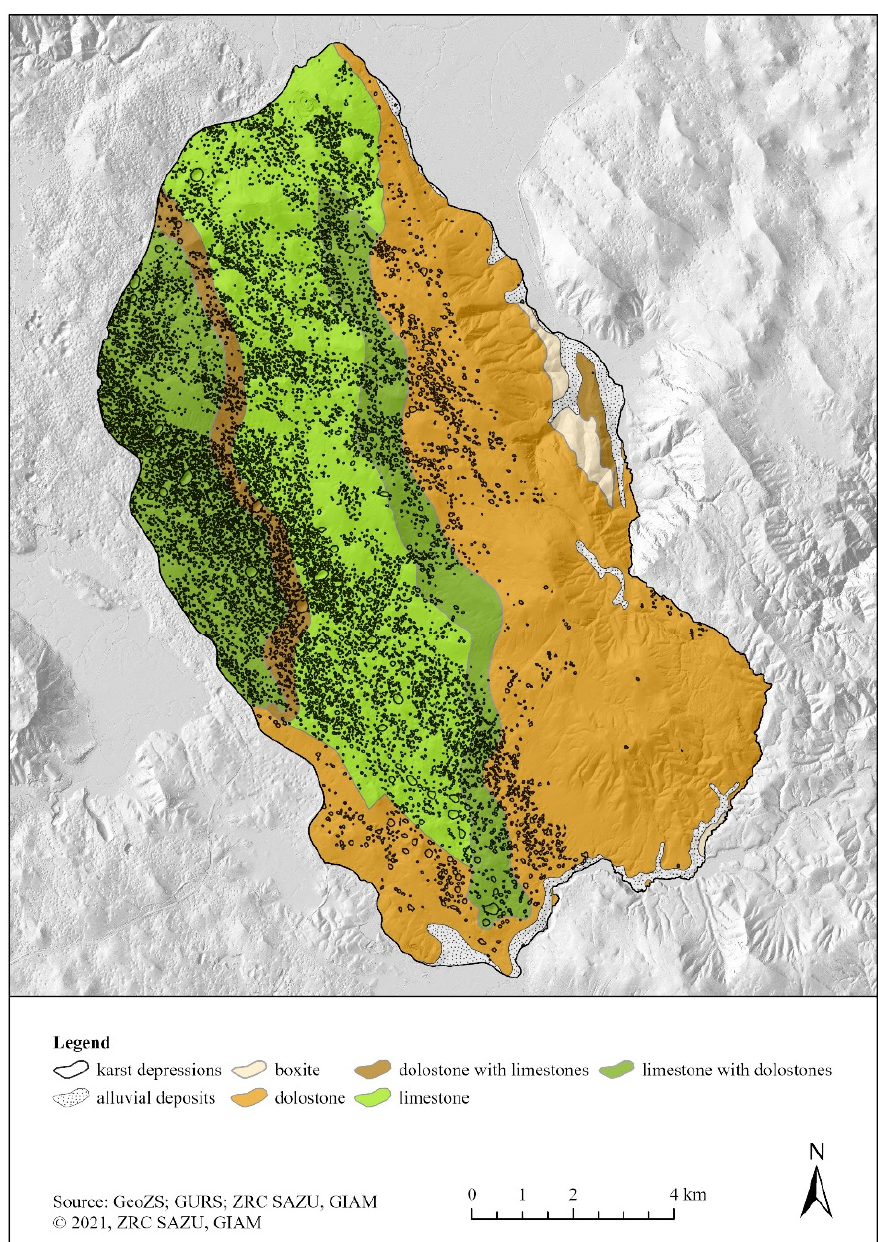
Figure 3. Detected karst depressions and geological map of the study area.